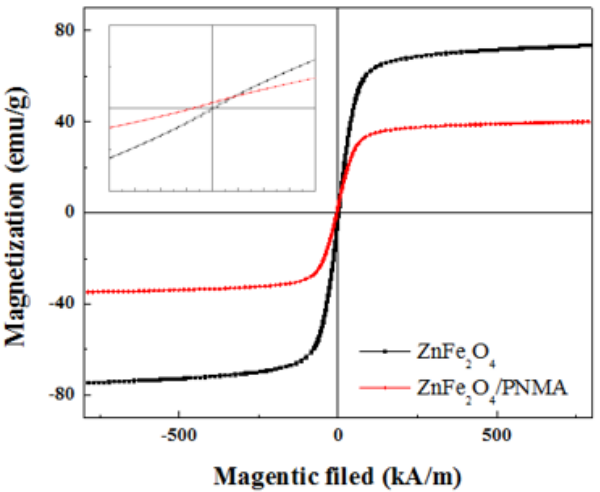
Figure 14. VSM of the ZnFe 2 O 4 /PMA-based 5 vol% MR fluid.